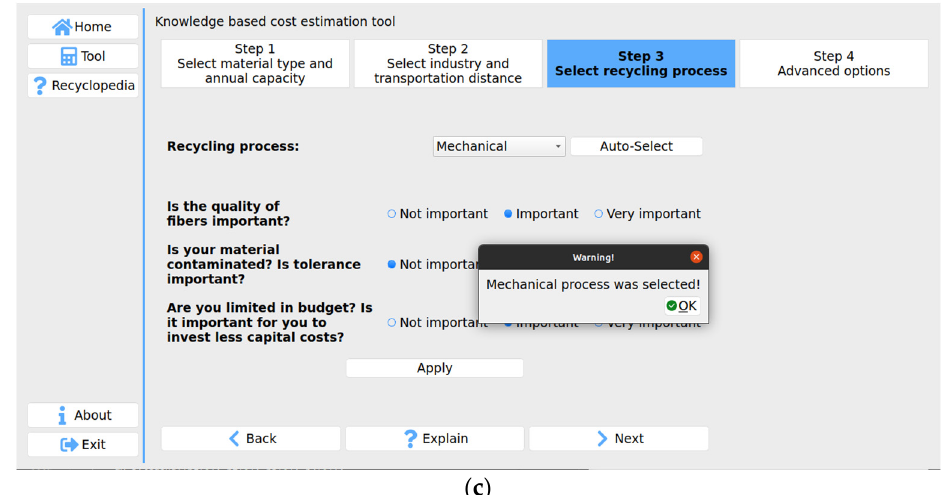
Figure 4. ( a ) Screenshot of material type selection and annual capacity; ( b ) industry sector selection; ( c ) recycling process recommendation.